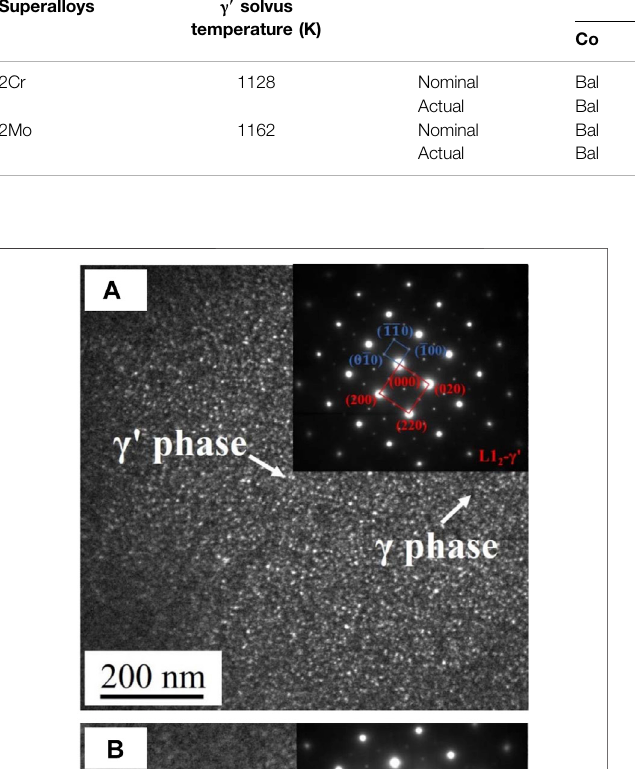
TABLE 1 | Chemical compositions (at%) and γ ′ solvus temperature (K) of 2Cr and 2Mo superalloys. Superalloys